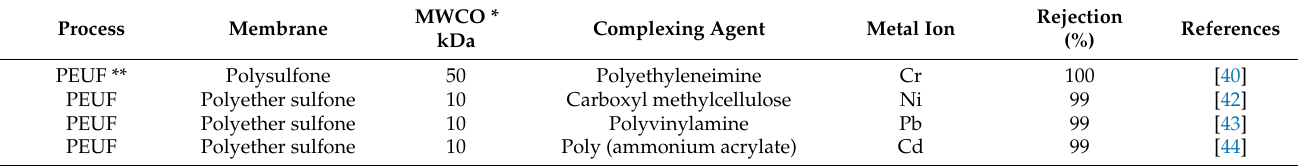
Table 6. Removal of heavy metal by using CEUF and MEUF processes. Process